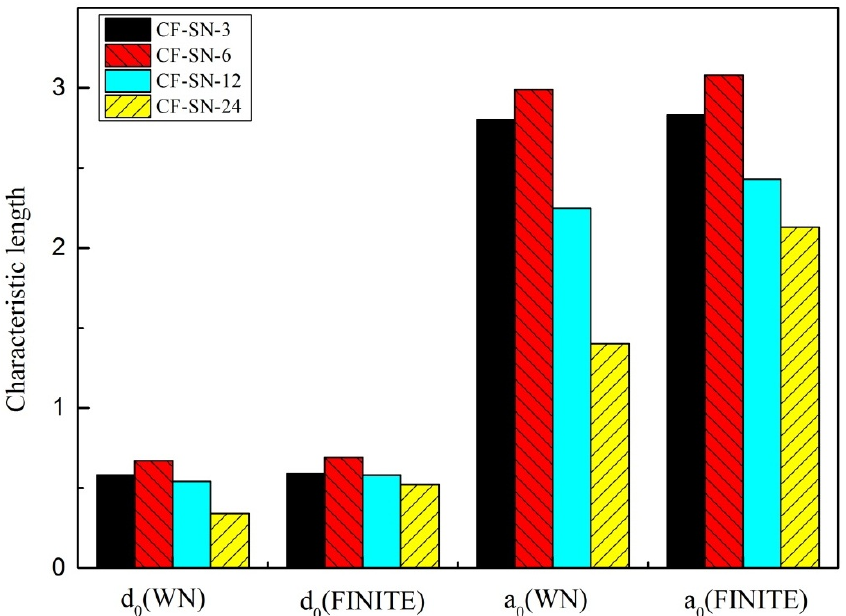
Figure 18. Characteristic lengths of the equal specimen size group calculated by the WN stress cri ‐ teria and finite ‐ width stress model; the characteristic lengths in this group calculated under the WN ‐ stress ‐ criteria ‐ based formula vary greatly, especially with a greater notch size.